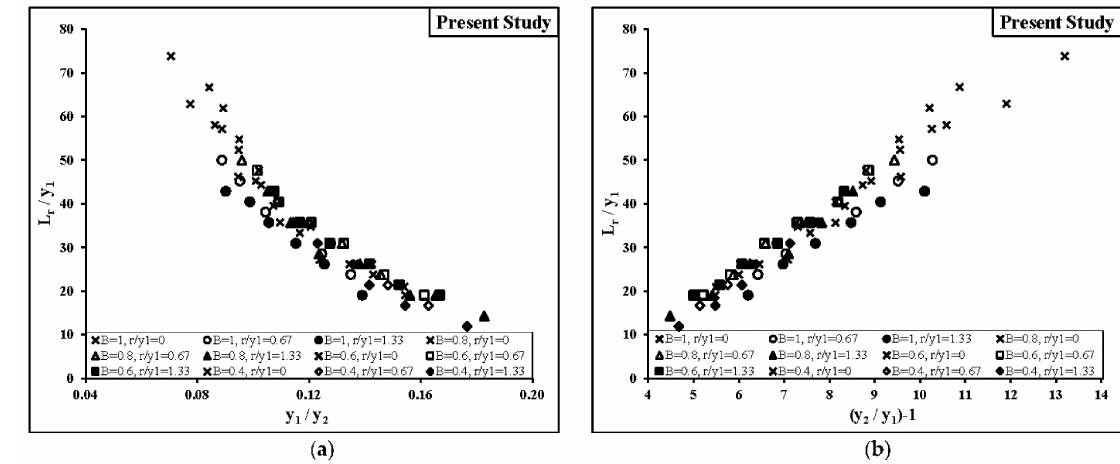
Figure 7. Relationship between the ratio of L r / y 1 and ( a ) the ratio of ( y 1 / y 2 ), ( b ) the difference (( y 2 / y 1 ) − 1) for all experimental data.